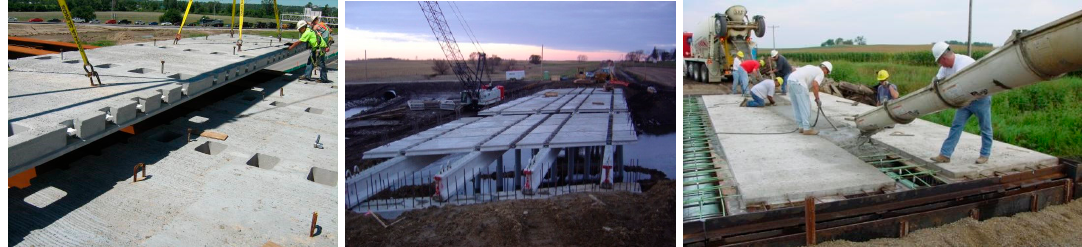
Figure 1. Examples of an accelerated bridge construction (ABC) process (Used with permission by Iowa DOT) [3].